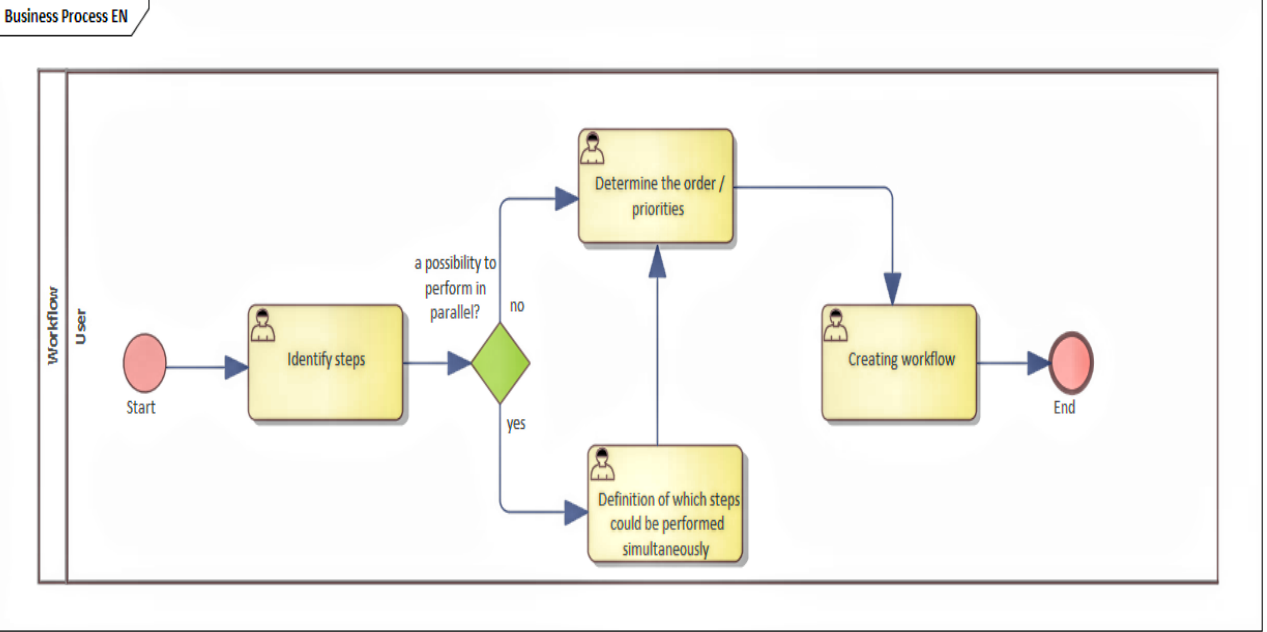
Figure 9. Identification of activities and creation of steps.